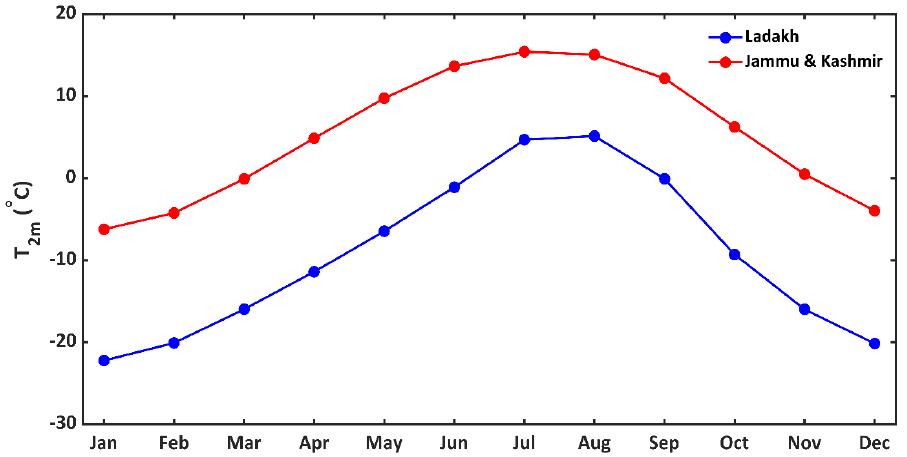
Figure 4 . Monthly distribution of averaged 2m-temperature from 1981 to 2020.